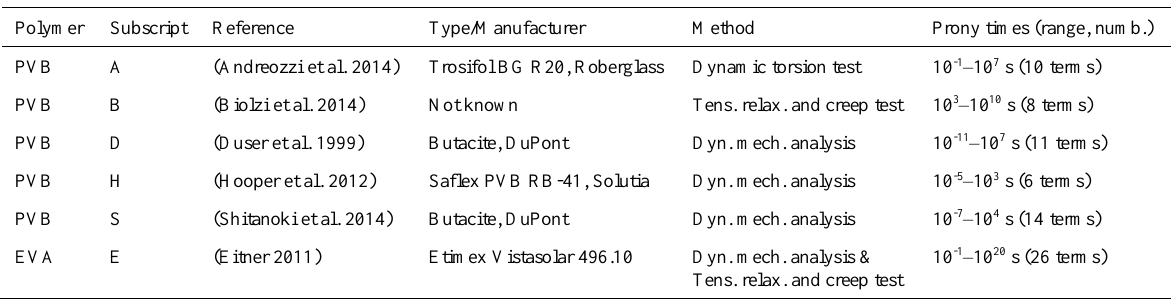
Table 1: List of used material parameters for PVB and EVA foils with references.